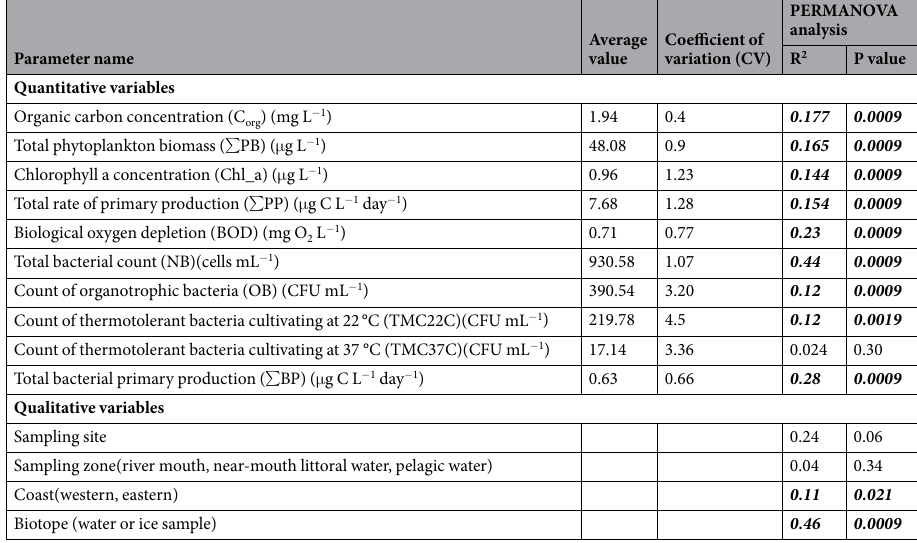
Table 2. PERMANOVA analysis results for the assessing the statistical significance of the influence of the biological parameters in sampling sites on the complex of hydrochemical